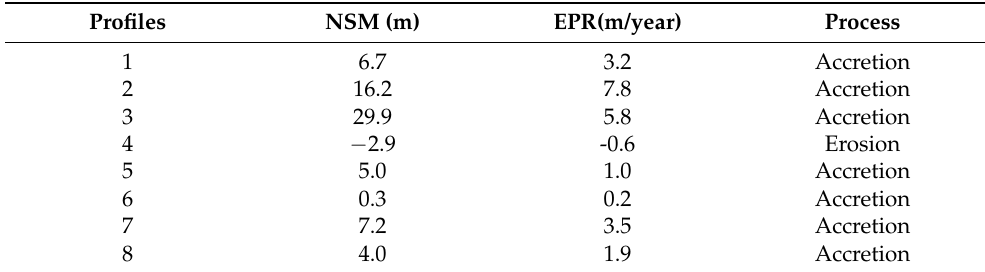
Table 2. Net Movement (NSM) and End Point Rate (EPR) for each profile.